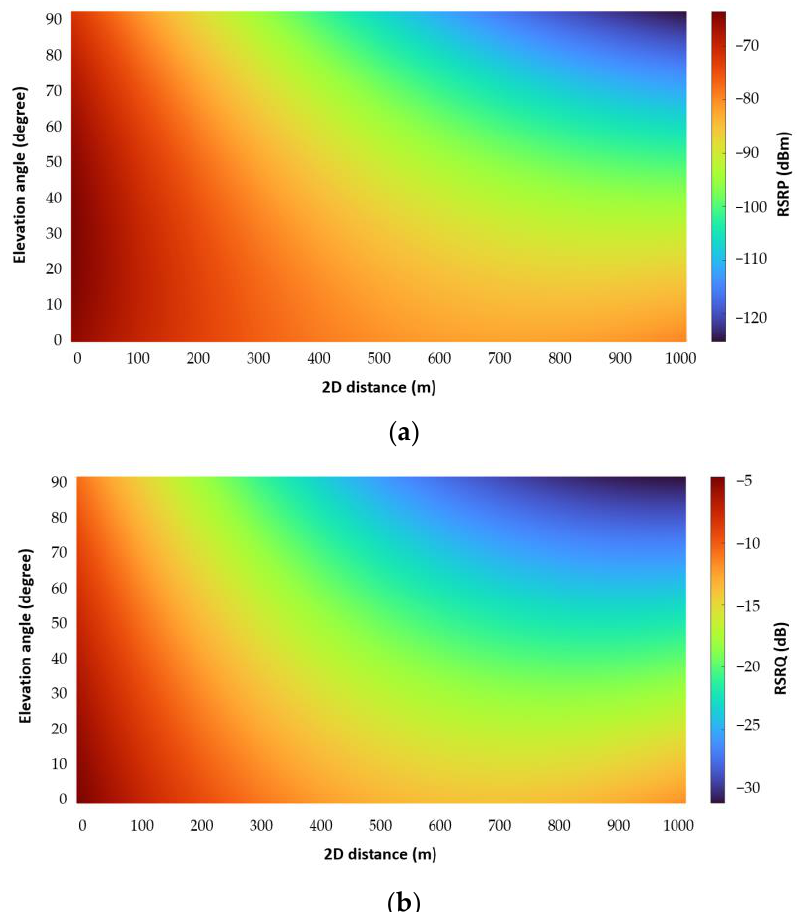
Figure 7. 2D representation of ( a ) RSRP and ( b ) RSRQ around a 4G BS.